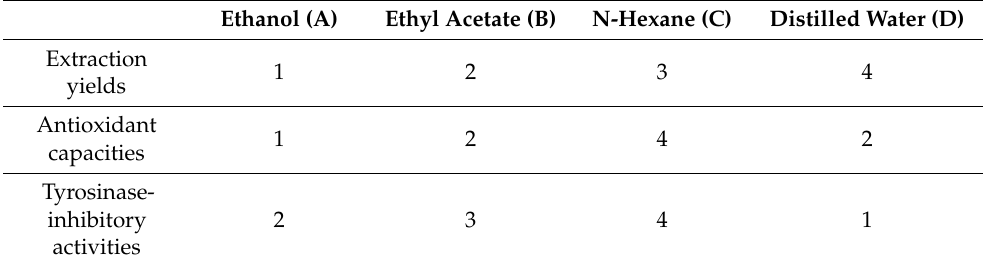
Table 7. Summary of the extraction yields, antioxidant capacities, and tyrosinase-inhibitory activities of the four solvent extracts of Hang